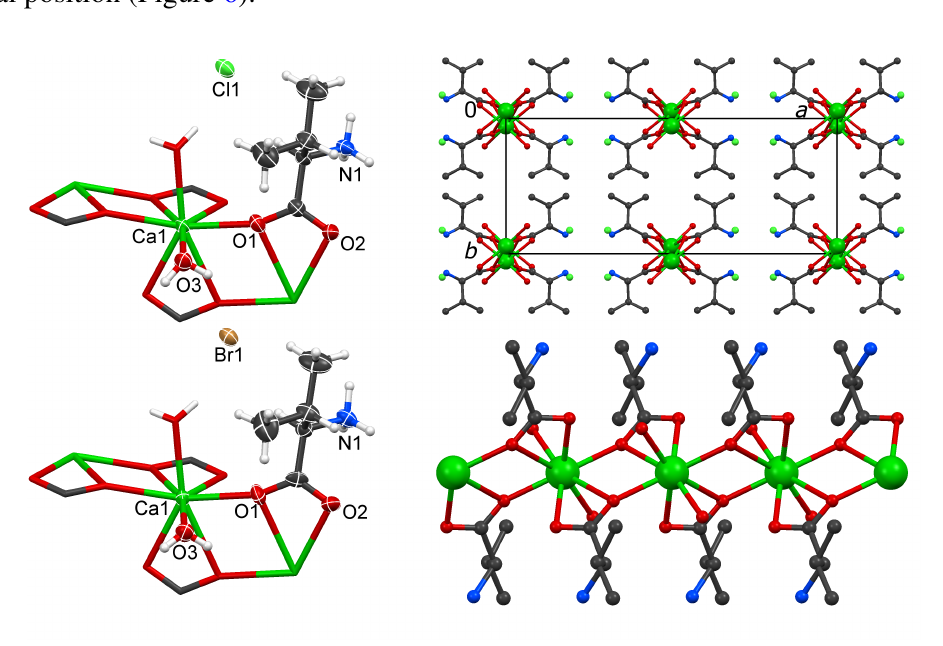
Figure 6. Left: Asymmetric units of 3 and 4 as displacement ellipsoid plots (80% probability) and adjacent atoms as stick model. Right: Packing of a cationic chain exemplary shown for 3 (hydrogen atoms omitted for